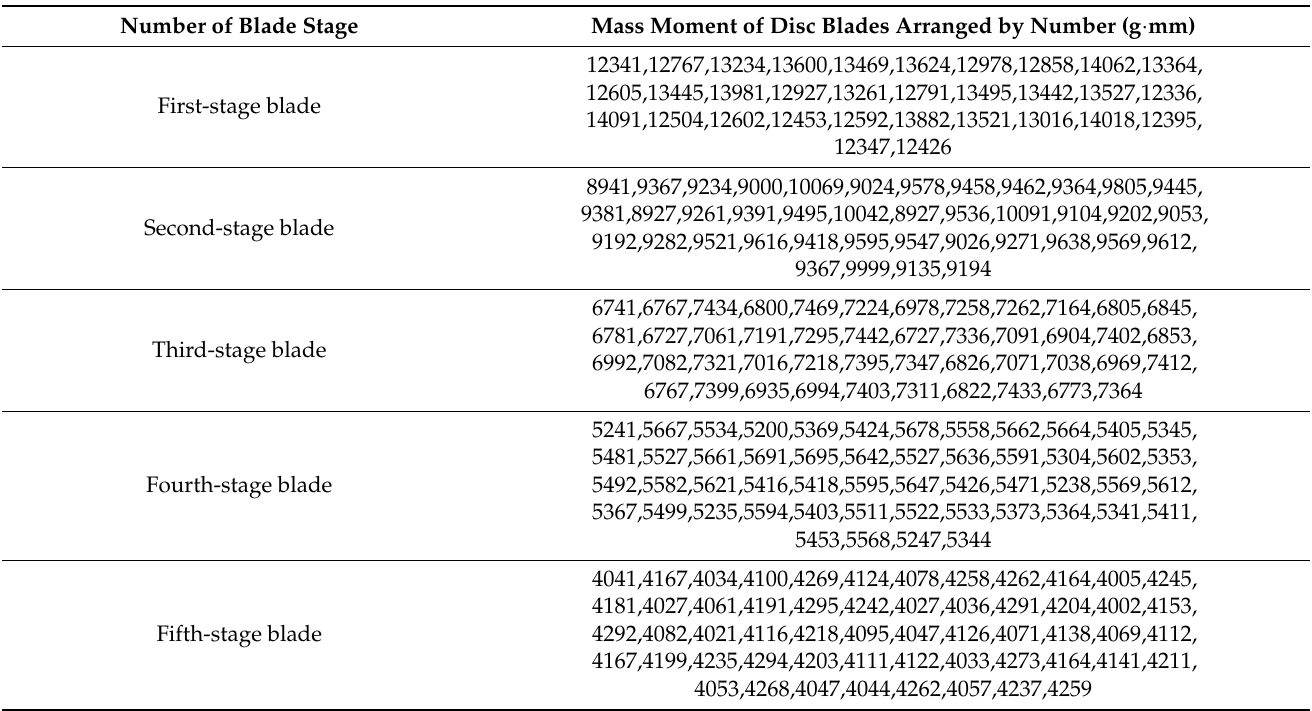
Table 5. Blade data of all rotors.